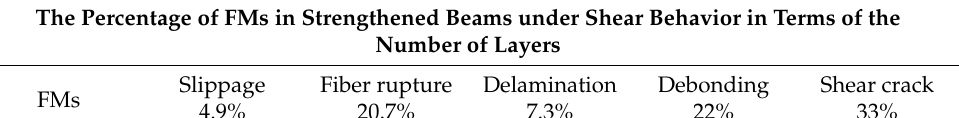
Figure 4. An increase in load-carrying capacity ratio versus: ( a ) number of layers and ( b ) composite type with respect to FMs. Table 7. The percentage of FMs in strengthened beams under shear behavior in terms of the number of layers.